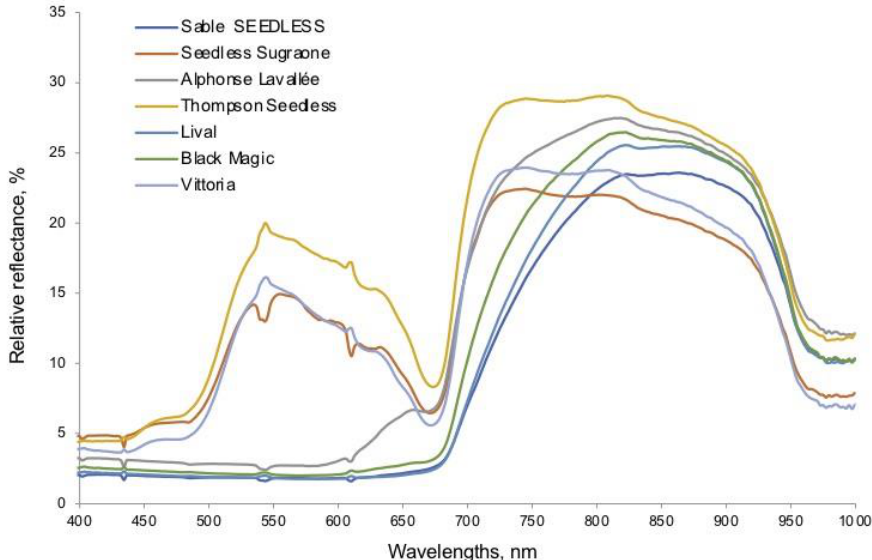
Figure 2. Mean reflectance spectra profiles obtained by hyperspectral imaging spectroscopy. Sable Seedless (dark blue), Seedless Sugarone (red), Alphonse Lavallée (green), Thompson Seedless (purple), Lival (turquoise), Black Magic (orange), and Vittoria (clear blue) table grapes samples.